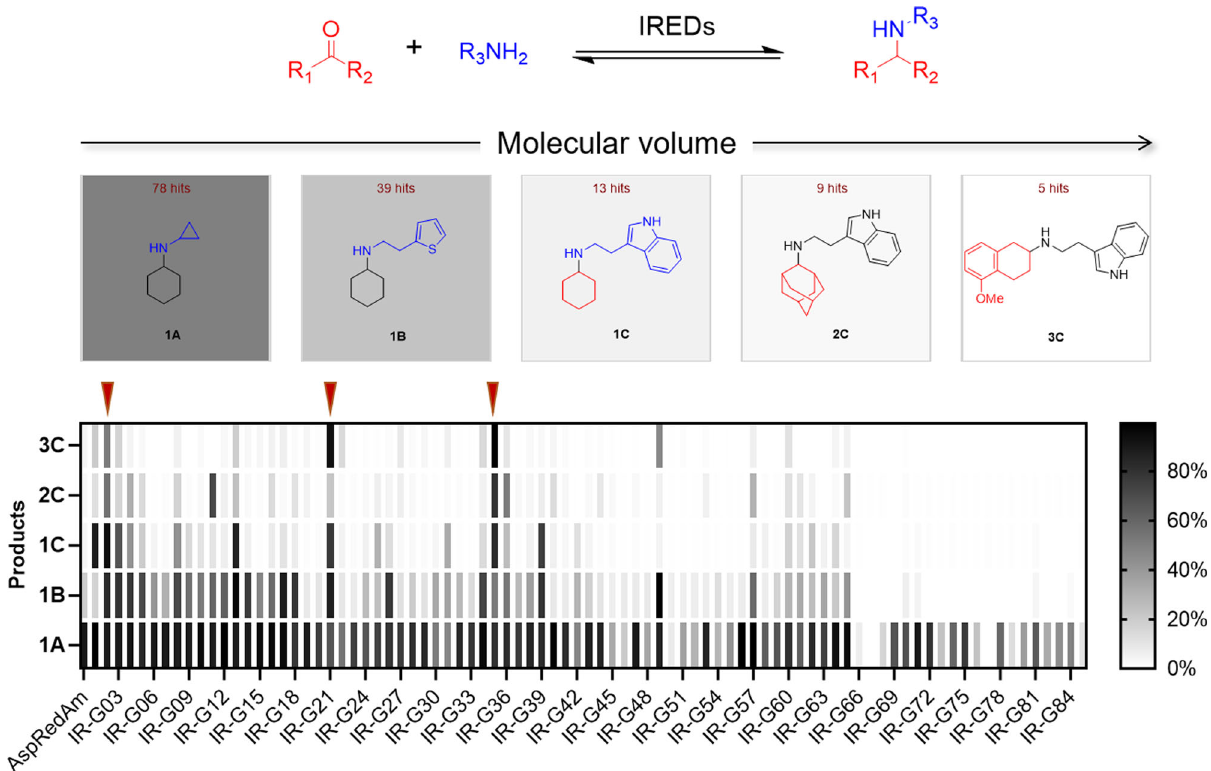
Fig. 2 Screening for IREDs using the increasing-molecule-volume-screening approach. The number of enzyme hits is shown above the structure of the corresponding secondary amine. The black color scale in each tile is representative of the number of hits generated through the screening with the given substrate. The standard assay mixture (50 μ L) contained 5.0 mM ketone, 5.0 mM amine, 1.0 mM NADP + , GDH (0.2 mg ml − 1 ), D-glucose (30 mM), 100 mM potassium phosphate buffer (pH 7.0), and 1 mg mL − 1 IREDs. The conversion of reductive amination products was determined by comparison with UV-Vis absorptions of synthesized standard reference materials. The enzymes (IR-G02, 21, and 35) with red triangle block are potent